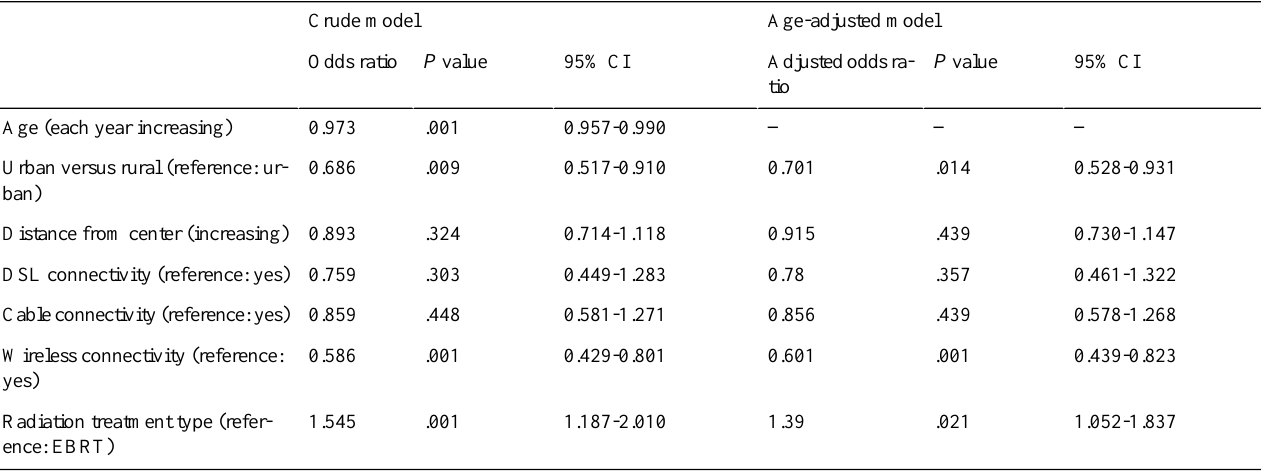
Table 2. Predictors for participation, represented in crude and age-adjusted odds ratios.